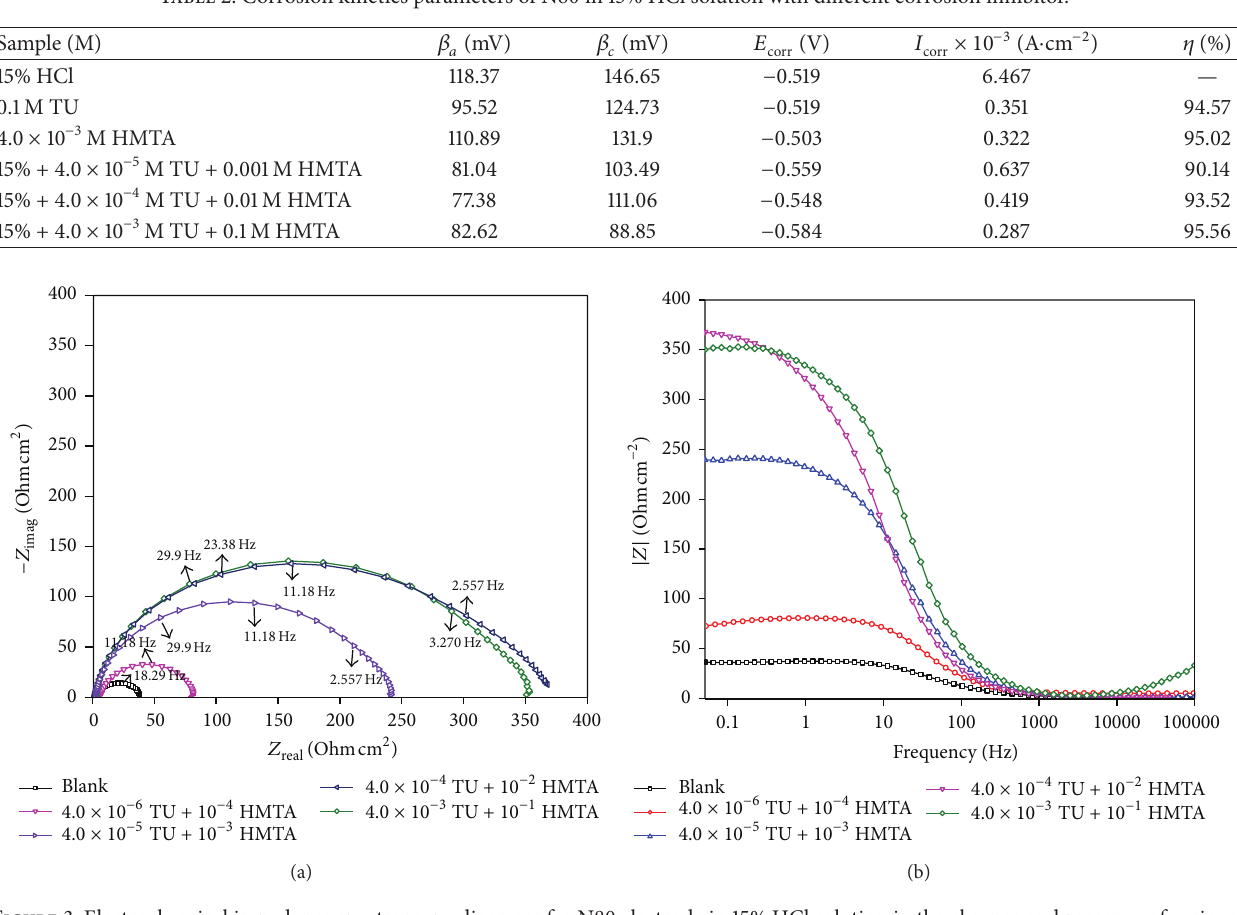
Figure 3: Electrochemical impedance spectroscopy diagrams for N80 electrode in 15% HCl solution in the absence and presence of various concentrations of a mix of both inhibitors, TU and HMTA, at 25 ± 1 ∘ C: (a) Nyquist plots, (b) Bode